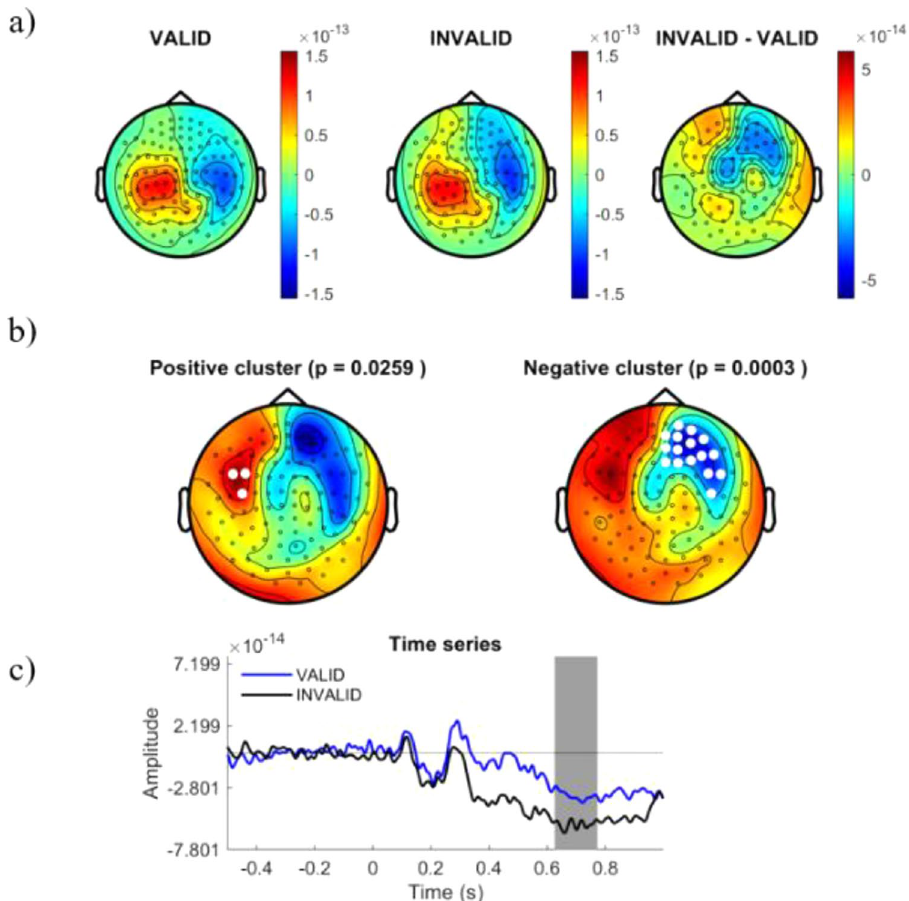
Figure 7. Represents the distribution of cortical activity in a time-slice from 625 to 775 ms. ( a ) Shows topographical maps of amplitudes for each condition (left and central map) and their arithmetic subtraction (right map). ( b ) Represents statistical differences (T values) between conditions. Left, positive cluster, and right, negative cluster. White dots represent sensors that showed significant differences during time-window. ( c ) Shows the whole time-series for both conditions (blue = VALID; black = INVALID). Grey mask represents time- slice of samples with significant